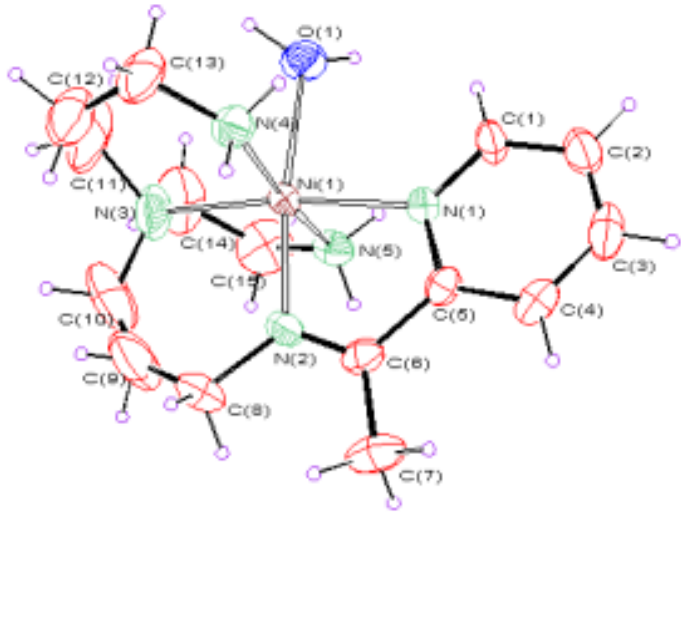
Figure 2. ORTEP plot of the complex [Ni(ppe-py)(H Perchlorate anions are omitted for clarity.